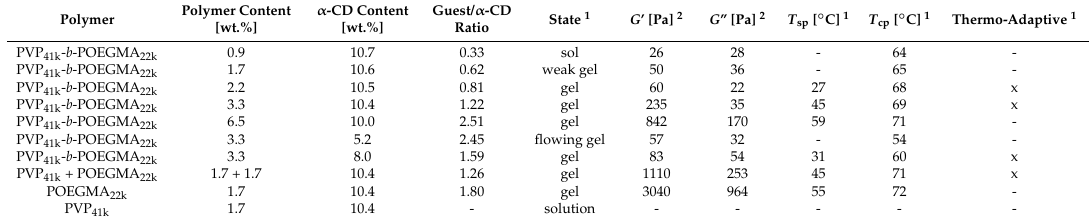
Table 1. Rheological properties and transition temperatures of DHBC-based supramolecular hydrogels. Polymer PolymerContent